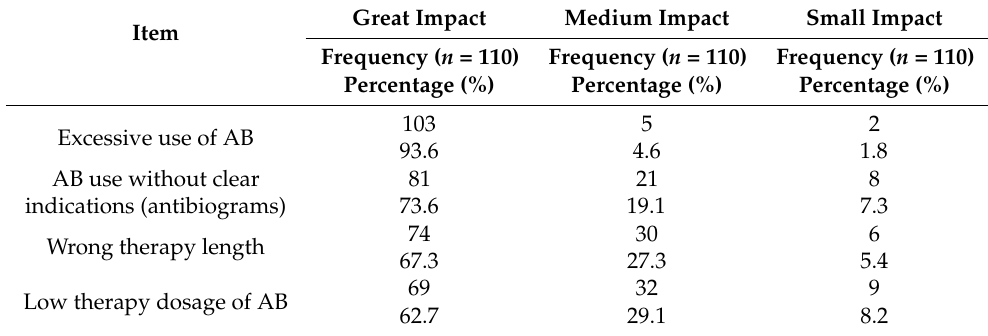
Table 7. Antibiotic therapy influences on the development of AMR.